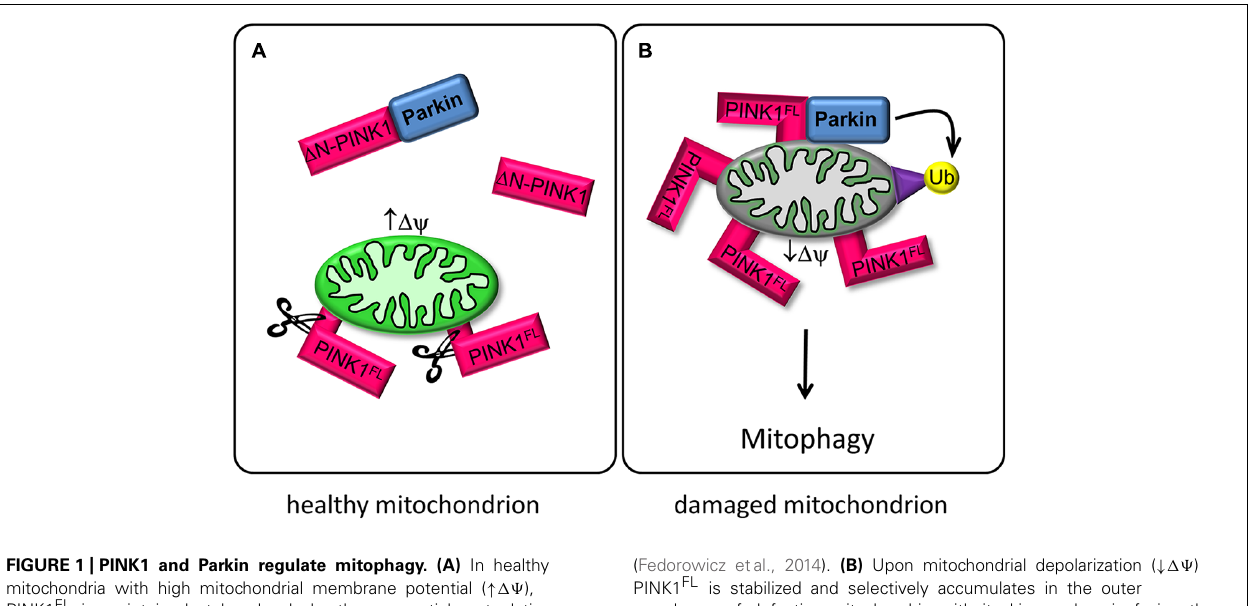
(Fedorowicz etal., 2014). (B) Upon mitochondrial depolarization ( ↓ (cid:2)(cid:3) ) PINK1 FL is stabilized and selectively accumulates in the outer membrane of defective mitochondria with its kinase domain facing the cytoplasm. This accumulation is a crucial signal for Parkin recruitment to impaired mitochondria, promoting ubiquitination of mitochondrial outer membrane proteins and subsequent disposal of the damaged organelle (Narendra etal.,